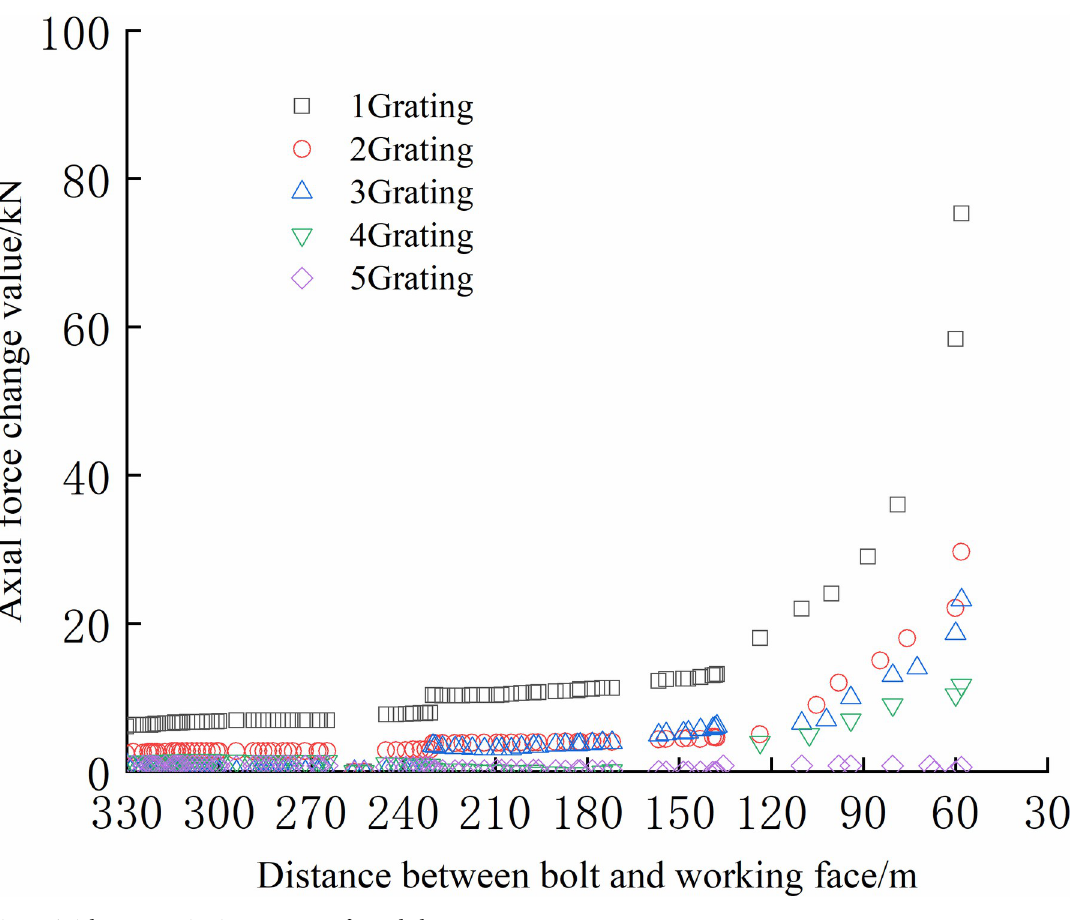
Fig 29. Axial stress monitoring test curve of No.6 bolt.